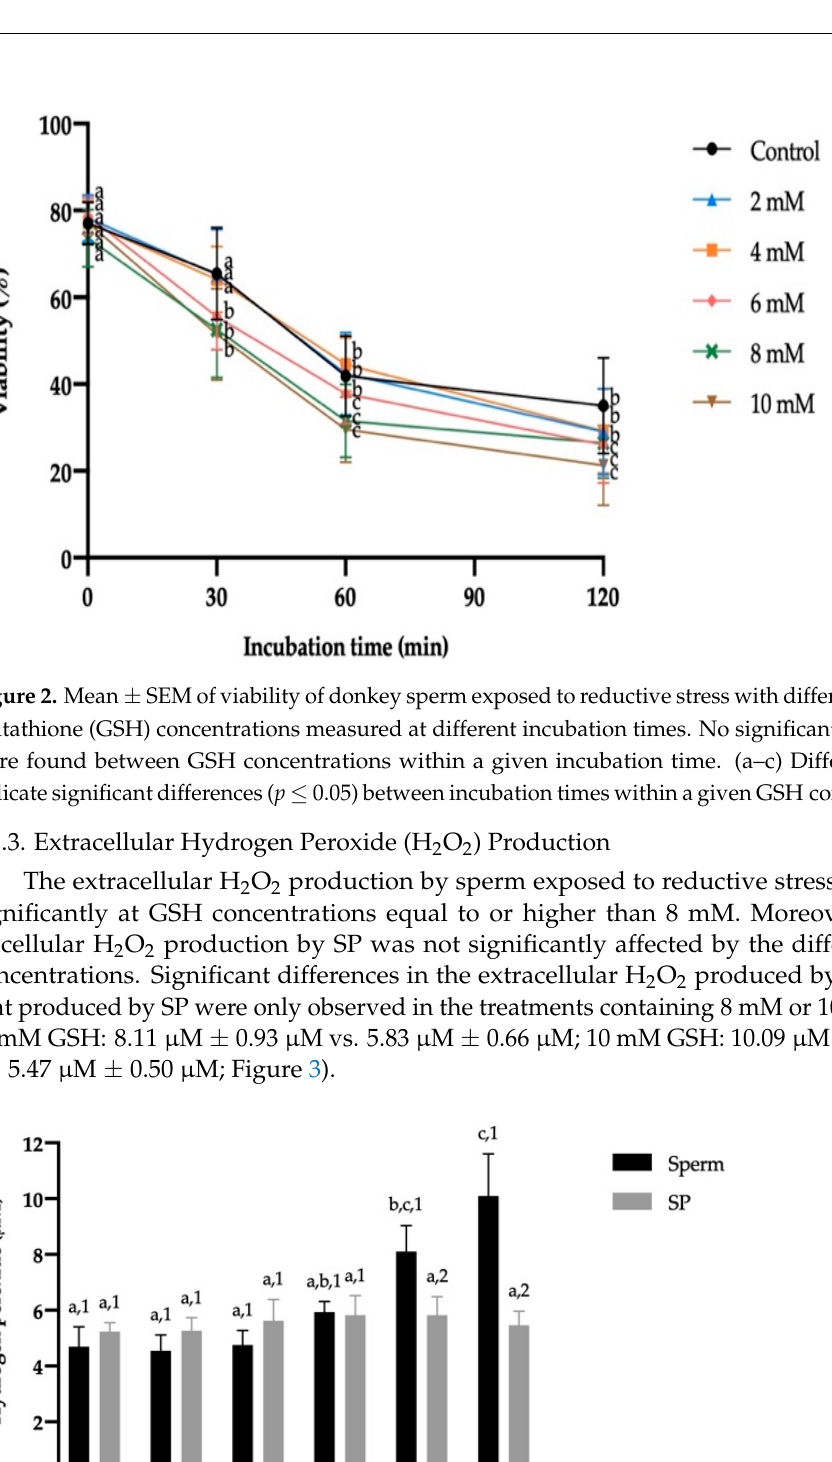
( b ) Figure 4. Mean ± SEM of total ( a ) and progressive ( b ) motility of donkey sperm exposed to oxidative stress with different hydrogen peroxide (H 2 O 2 ) concentrations measured at different incubation times. No significant differences were found between H 2 O 2 concentrations within a given incubation time. (a,b) Different letters indicate significant differences ( p ≤ 0.05) between incubation times within a given H 2 O 2 concentration. Regarding kinematic parameters (Table 2), the presence of 10 mM H 2 O 2 led to a re- duction in sperm velocity (VCL, VSL and VAP) after 30 min of incubation ( p ≤ 0.05). While LIN, WOB and BCF were not significantly affected by treatment at any of the incubation times, STR increased in 10 mM H 2 O 2 after 60 min and 120 min of incubation ( p ≤ 0.05),